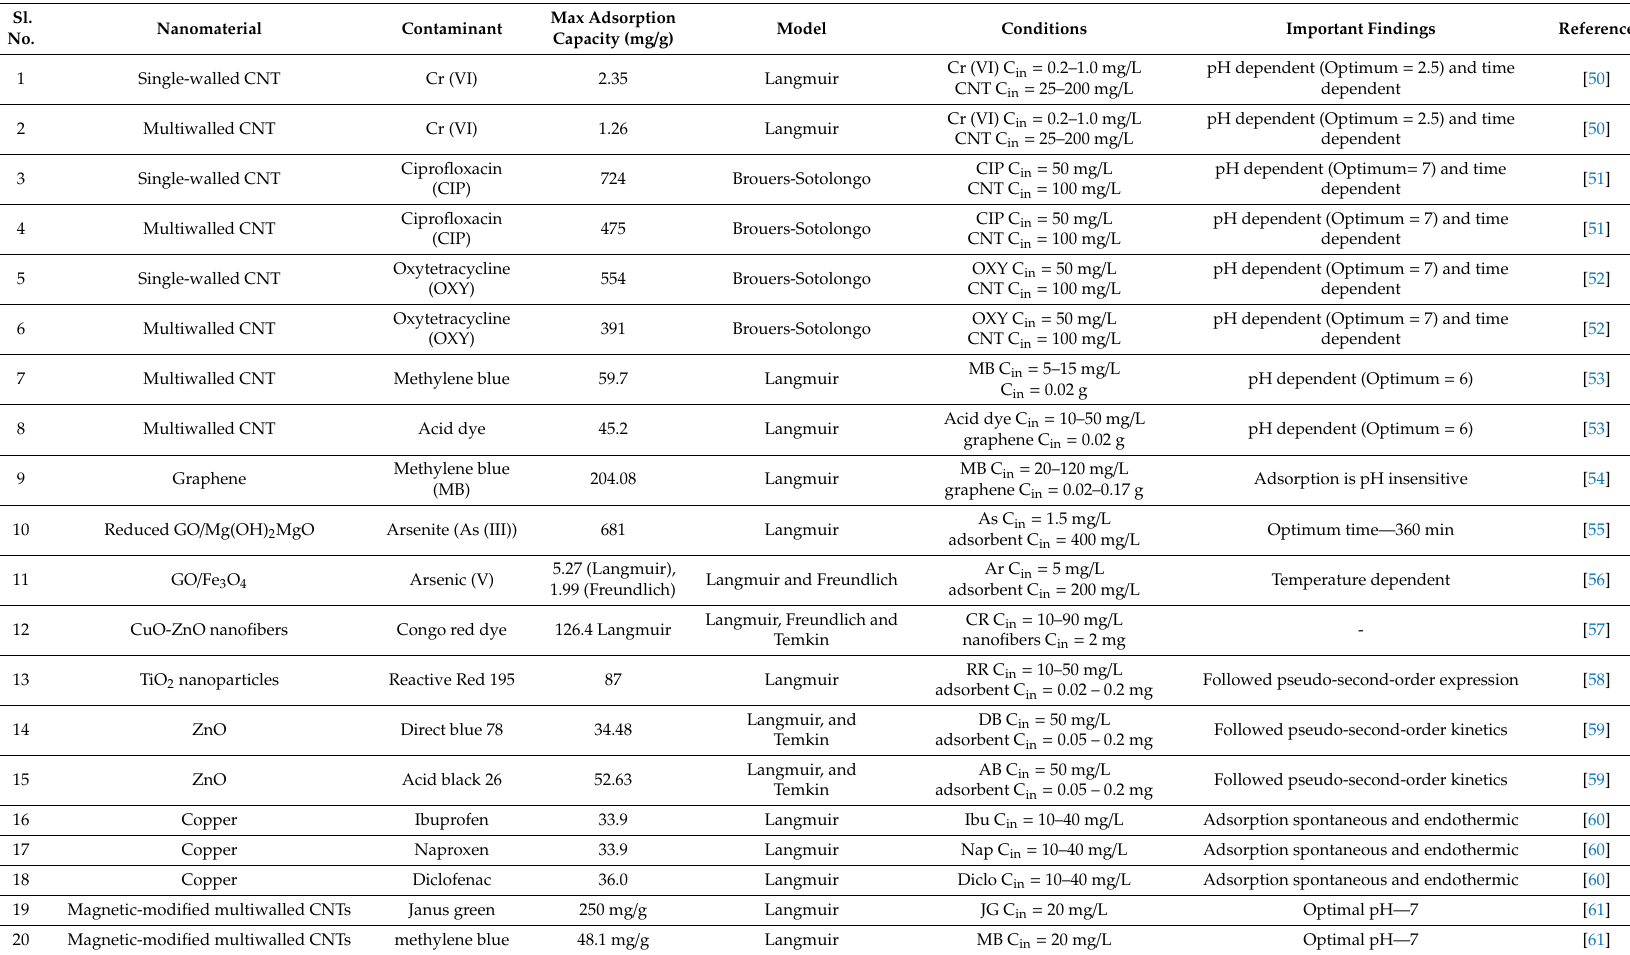
Table 2. Summary of the removal of di ff erent contaminants by some of the nanoadsorbents. Sl.